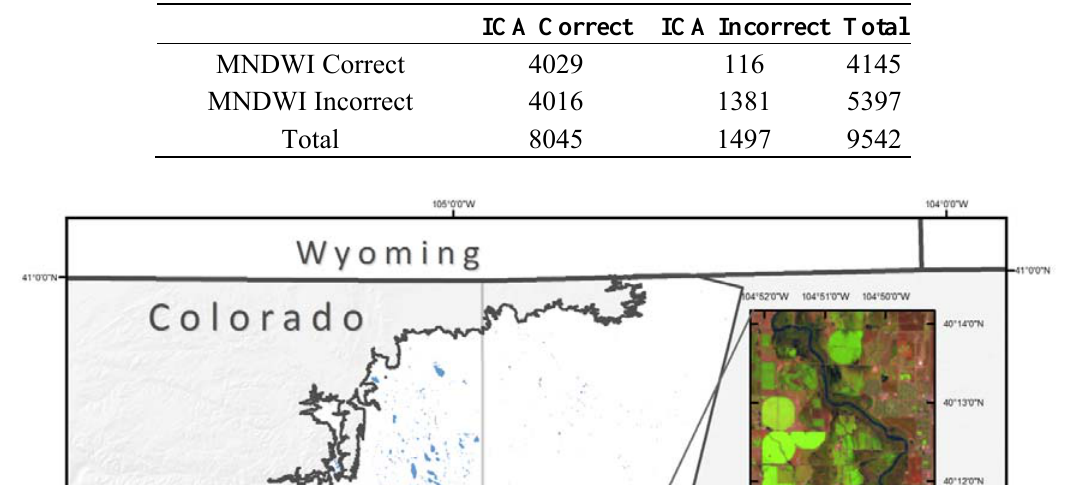
Table 3. Results of McNemar test between ICA and post-MNDWI.